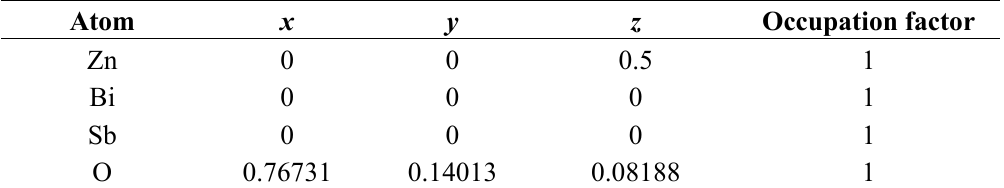
calcinated at 800 °C for 35 h. 4